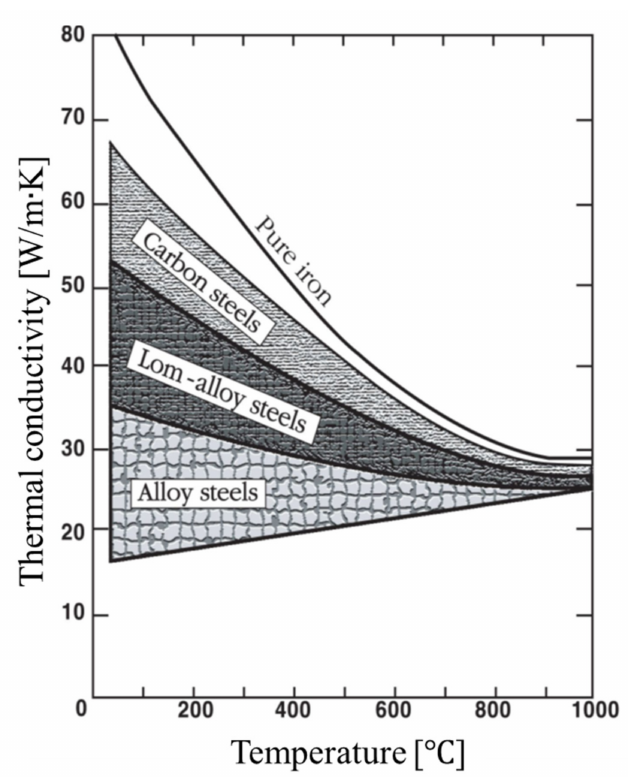
Figure 1. Thermal conductivity rate by rebar type